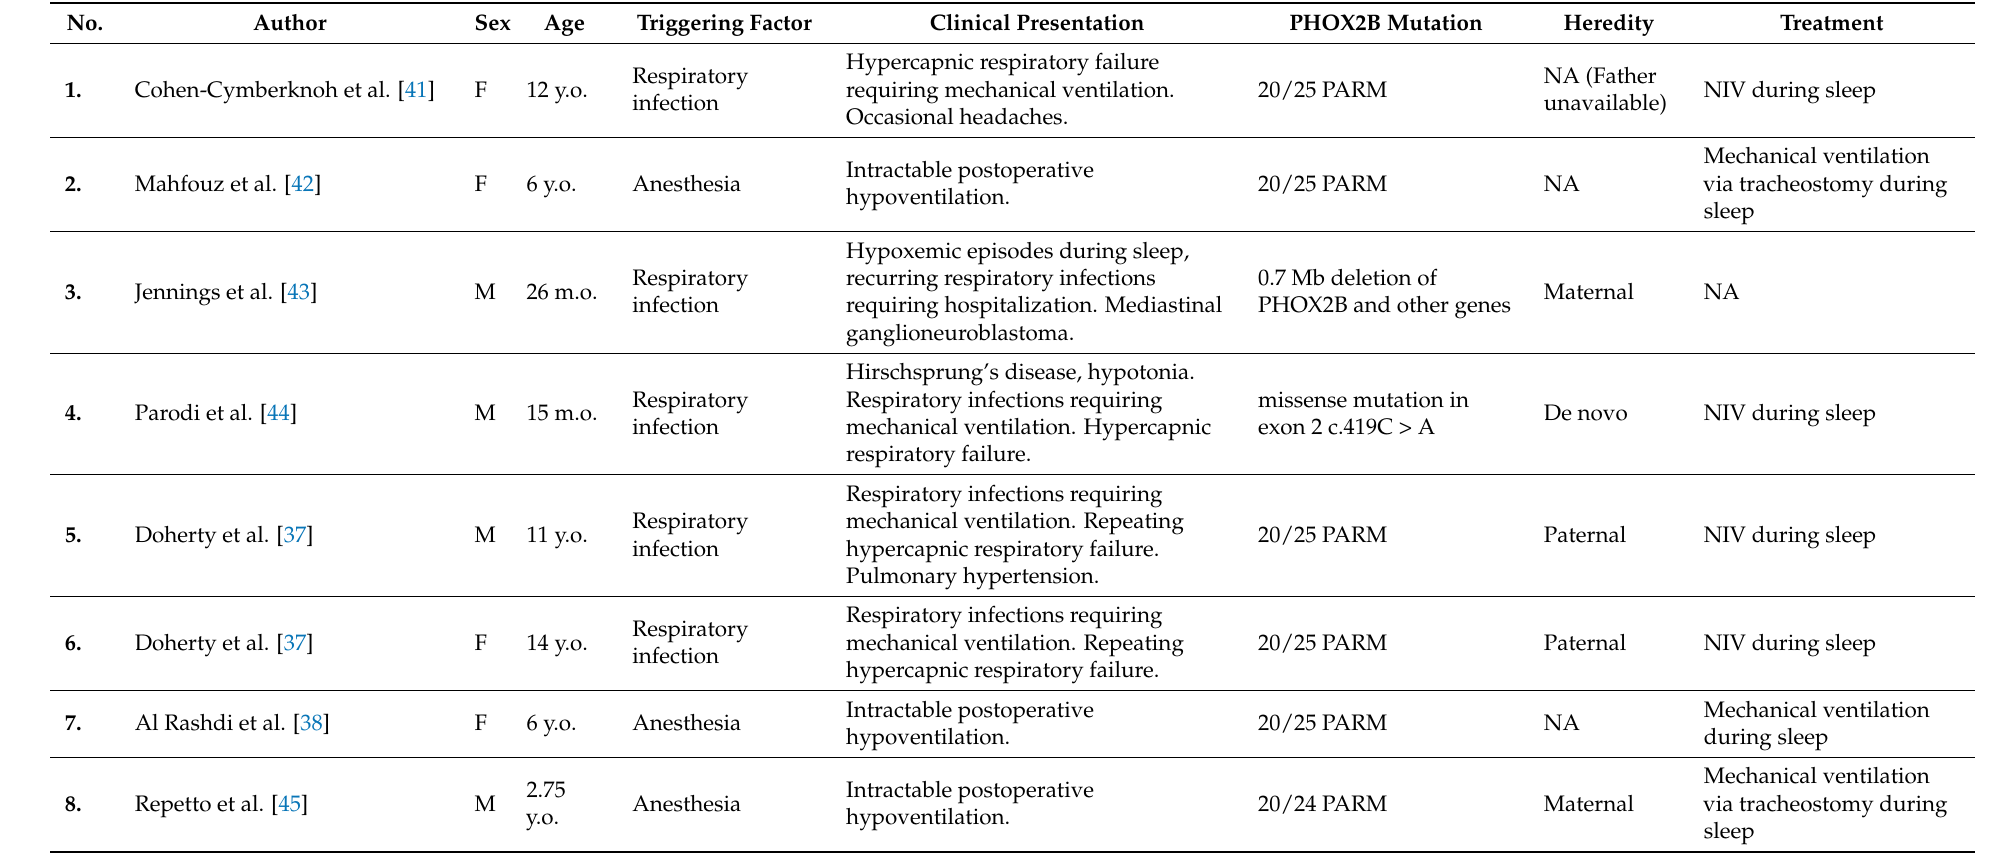
Table 1. Late onset pediatric central congenital hypoventilation syndrome, literature